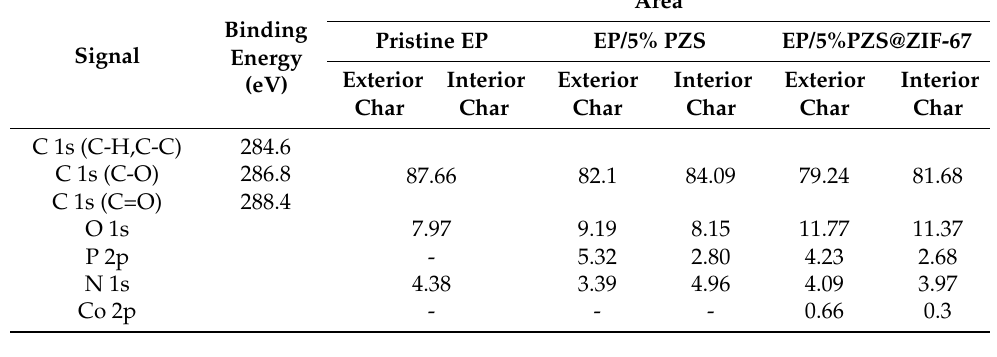
Table 6. XPS data of the residual chars of Pristine EP, EP/5% PZS, and EP/5% PZS@ZIF-67.